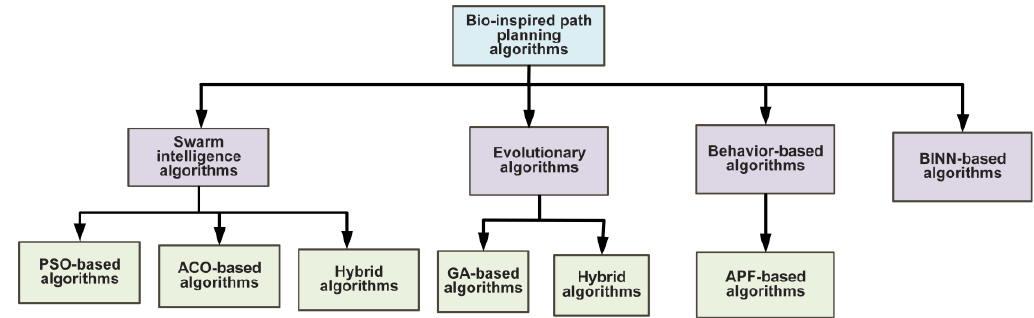
Figure 2. Classification hierarchy of bio-inspired path planning algorithms for UAVs.